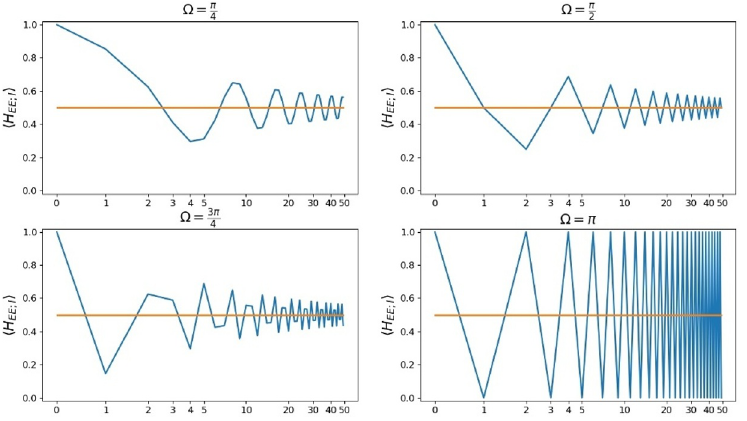
Figure 5 . FW spectra of h H EE ; l i for a system of two partons with equal energy and varied included angle (cid:10). The orange lines at h H EE ; l i = 0 : 5 represent the contribution from particle self-correlation to each FW